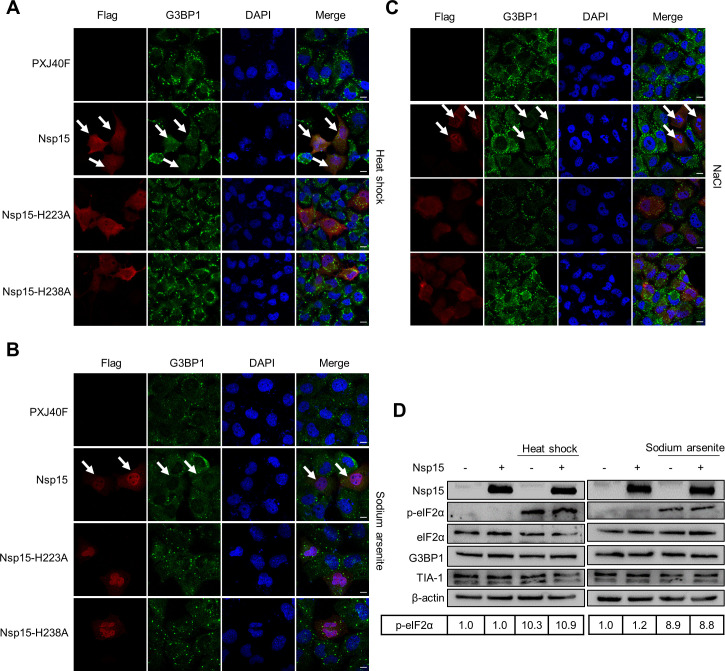
IBV nsp15 endoribonuclease activity is required for inhibition of eIF2α-dependent and -independent formation of SGs.(A-C) H1299 cells were transfected with plasmids encoding IBV nsp15, nsp15-H223A, or nsp15-H238A, respectively. At 24 h post-transfection, cells received heat shock, sodium arsenite, or NaCl treatment. Nsp15, nsp15-H223A, and nsp15-H238A were detected with anti-Flag antibody (red) and G3BP1 was detected with anti-G3BP1 (green). Cell nuclei were stained with DAPI (blue). The representative images of three independent experiments were shown. Scale bars: 10 μm. (D) H1299 cells were transfected with plasmids encoding IBV nsp15 or with vector PXJ40F. At 24 h post-transfection, cells received heat shock or sodium arsenite treatment. Cell lysates (10 μg/lane) were subjected to Western blot analysis, to check the expression of Flag-nsp15 and to determine the levels of phospho-eIF2α, eIF2α, G3BP1, TIA-1, and β-actin. The representative data of two independent experiments were shown. The signals of protein bands were determined by Image J. The intensities of p-eIF2α were normalized to total eIF2α. The ratio of p-eIF2α in nsp15-transfected cells, heat shock-treated cells, soduim arsenite-treated cells, to vector PXJ40F-transfected cell, were shown as p-eIF2α.